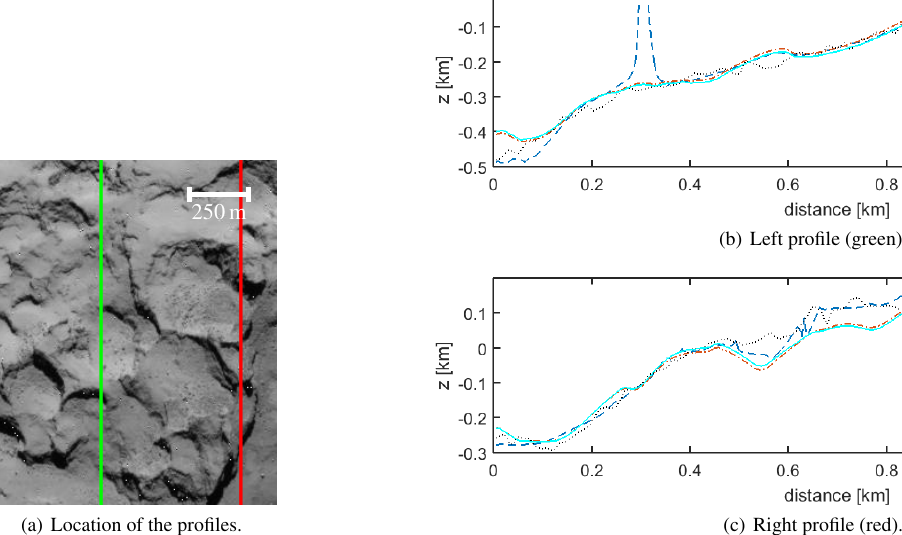
Figure 5: Depth profiles. All profiles run from top to bottom. (a) The location of the left (green) and right (red) profiles are shown on the NavCam image. (b) Left profile. (c) Right